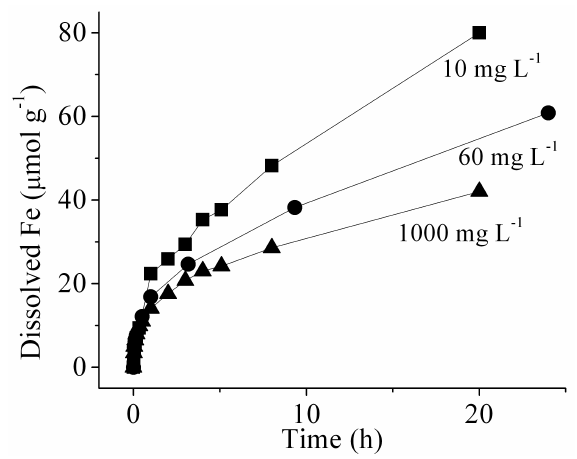
Fig. 3. Fe dissolution of Beijing dust at pH 1 at dust/solution ratios of 10, 60, and 1000mgL − 1